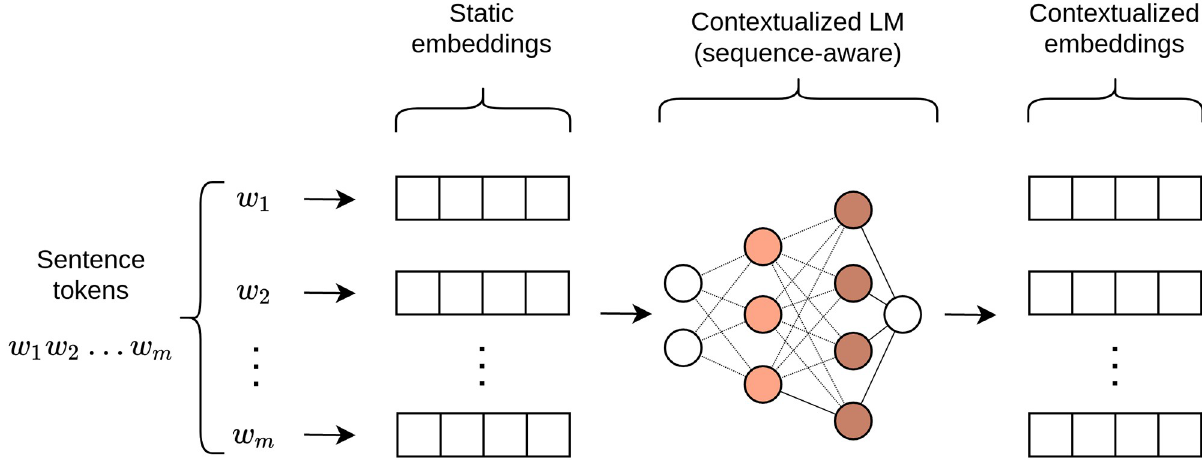
Fig 1. Sample generation process for contextualized